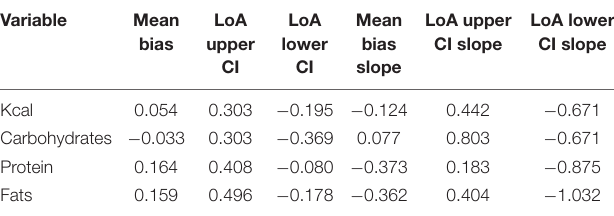
Legend: CI, 95% confidence